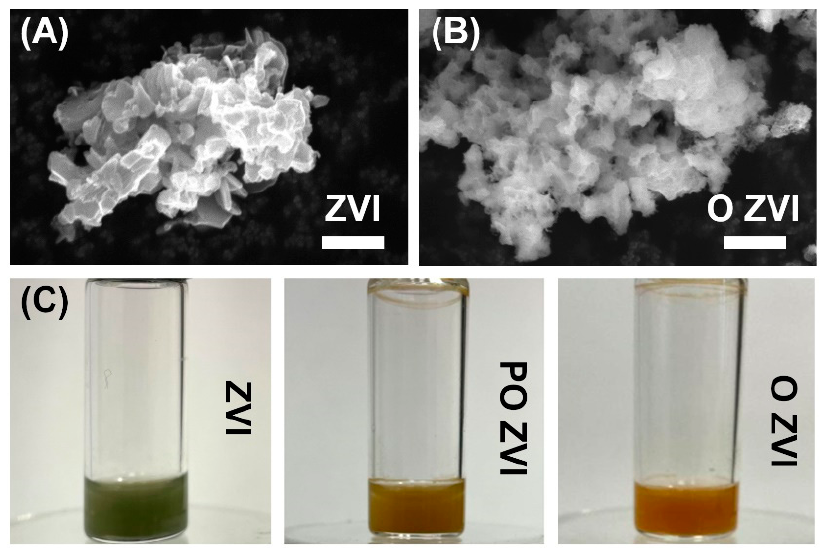
Figure 1. SEM pictures of ( A ) pristine (reduced) ZVI and ( B ) oxidized ZVI (O ZVI). Scale bars correspond to 1 µ m. ( C ) Visual discrimination between ZVI, partially oxidized ZVI (PO ZVI), and oxidized ZVI (O ZVI).